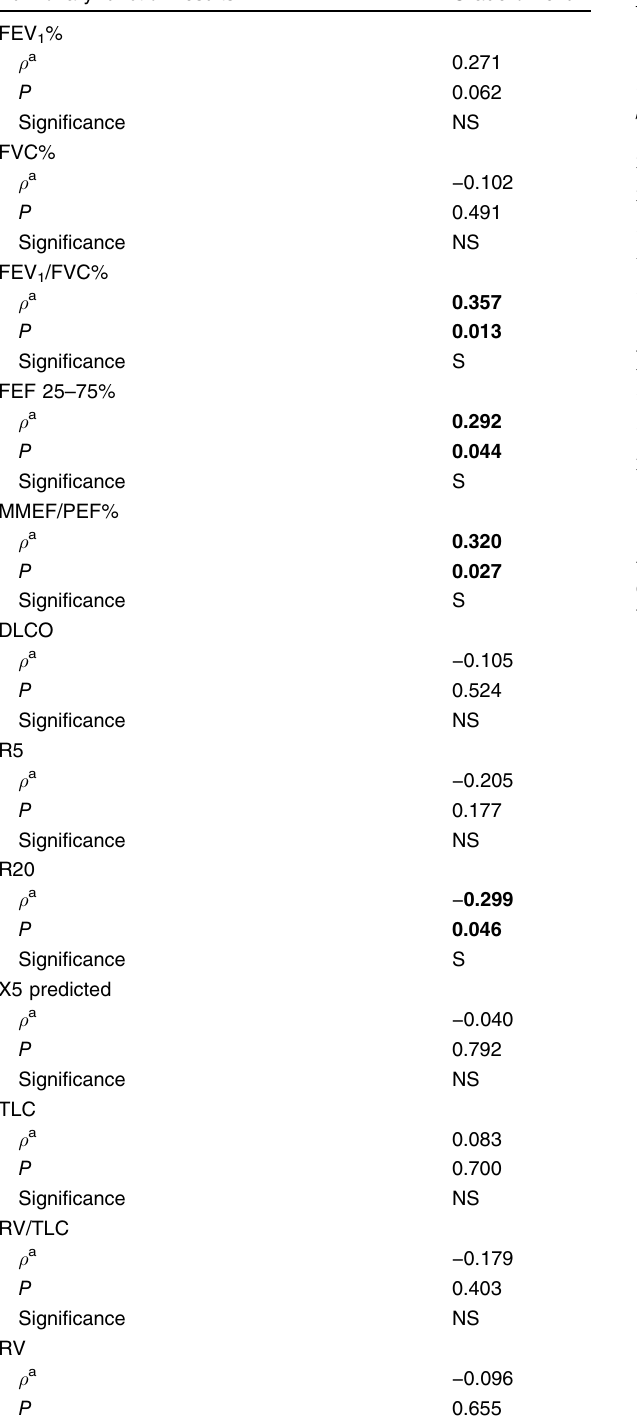
Table 6 Correlation between grade of reflux and PFT parameters Pulmonary function